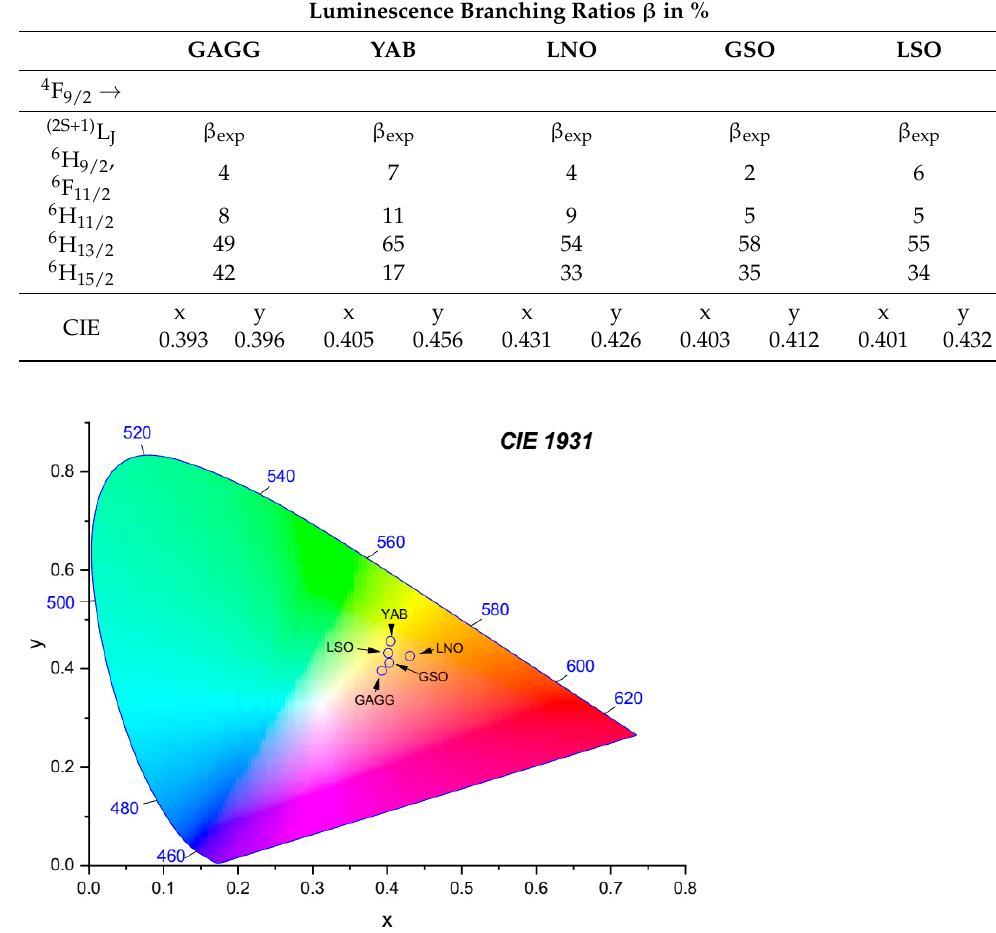
Table 2. Experimental luminescence branching ratios β of the Dy 3+ 4 F 9/2 → (2S+1) L J transitions and determined CIE values.